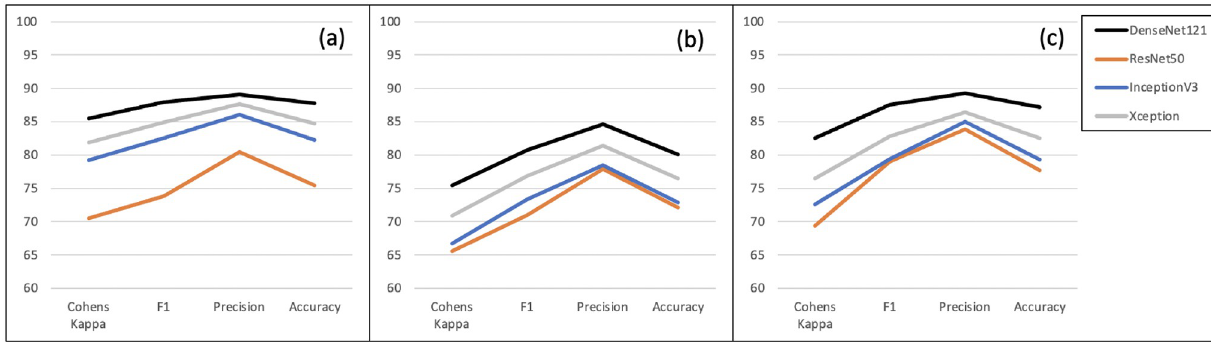
Fig 3. Performance metrics for the four chosen architectures on (a) Test set 1, (b) Test set 2 and (c) Test set 3.